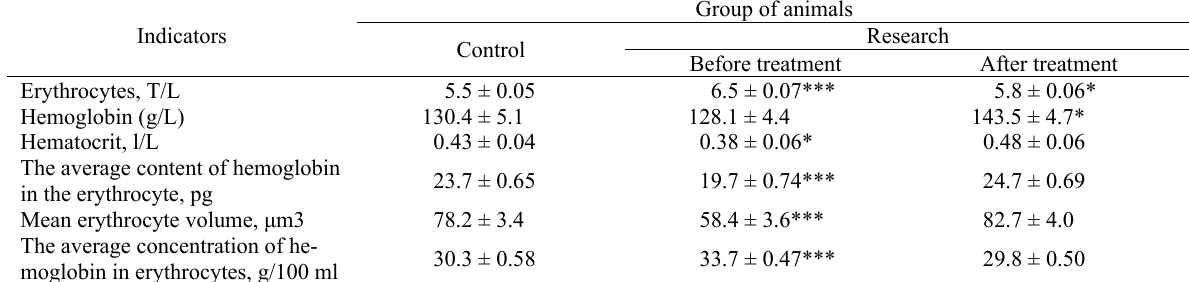
Group of animals